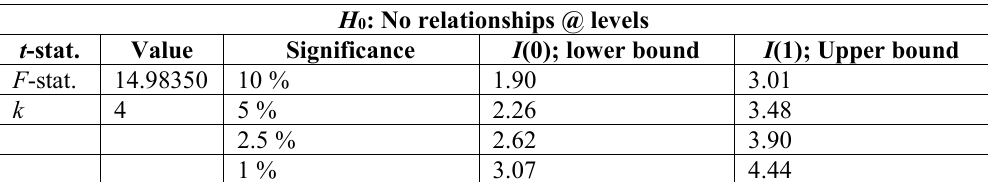
Table 3. Bounds Test Results (The authors’ computation, 2021)